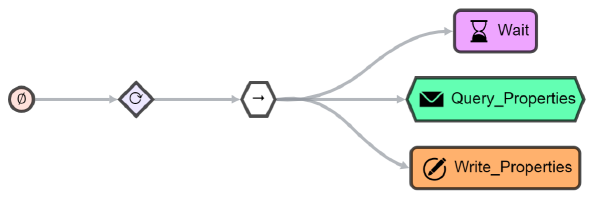
Figure 11. SBT of a monitor agent